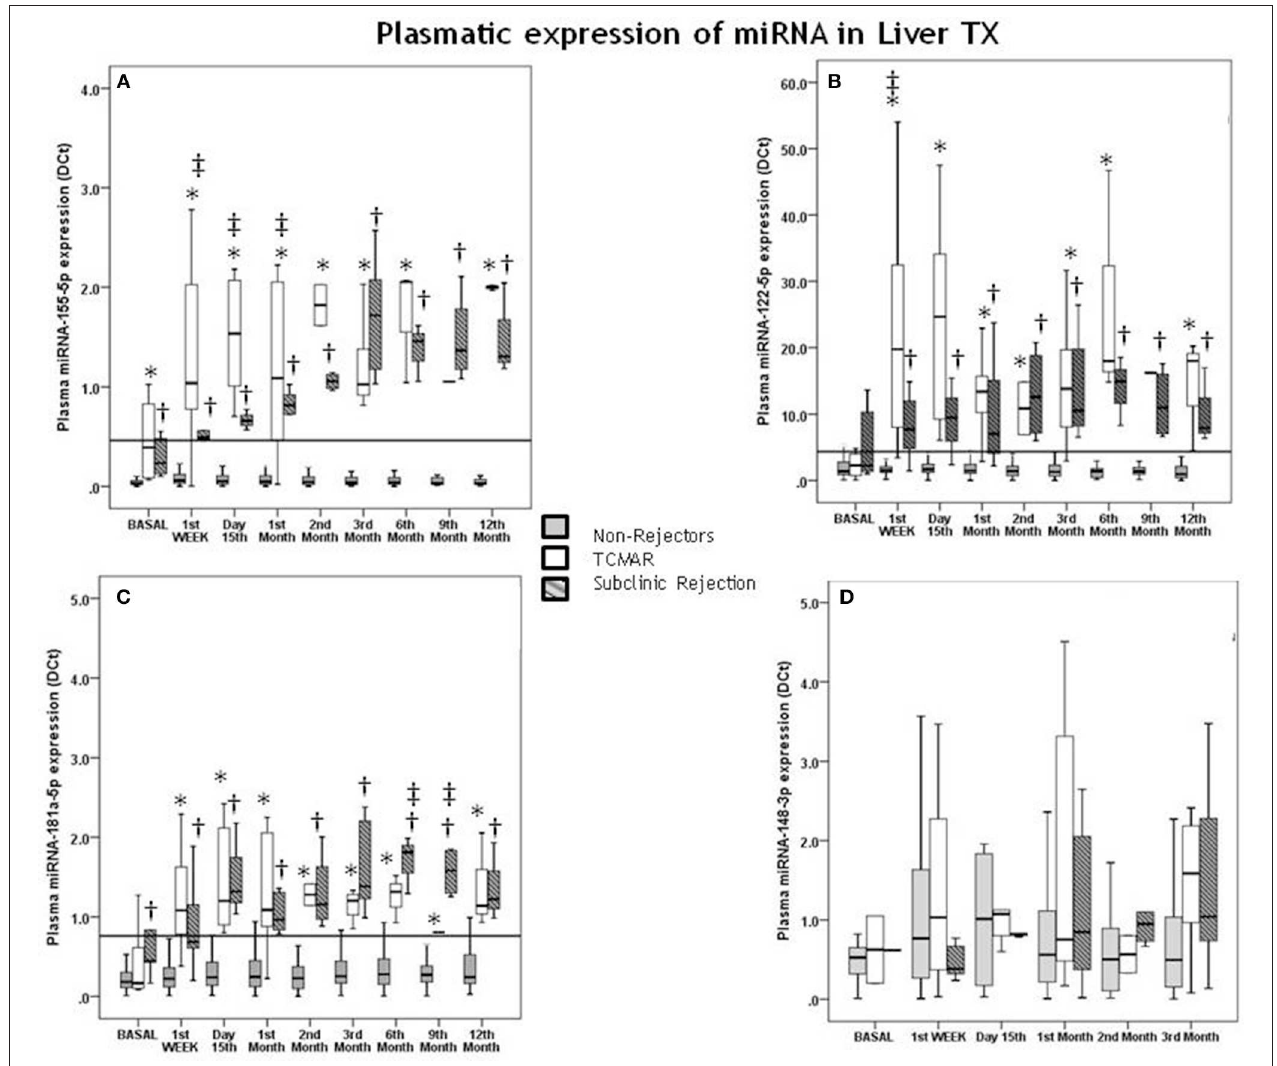
FIGURE 1 | Correlation of pre- and post-transplantation plasmatic miRNA expression with acute rejection (TCMAR) and subclinical rejection (SCR). Differences between TCMAR patients (white boxes), non-rejectors (gray boxes) and subclinical rejectors (gray hatched boxes) with respect to miR-155-5p (A) , miR-122-5p (B) , miR-181a-5p (C) , and miR-148-3p expression (D) , over 1 year post-transplantation. Seventeen of the 145 patients experienced TCMAR episodes (3 episodes occurred during the 1st week post-transplantation, 6 at day 15th, 4 at the end of the 1st month, 1 during the 3rd month, 1 during the 6th month, and 2 during the 12th month post-transplantation). Eight patients were diagnosed with SCR and were considered an independent group. TCMAR box-plots include data from the patients who exhibited rejection at this time plus the pre-TCMAR data of the patients who had not yet exhibited rejected at this time but who would do so in a later profile. Therefore, the number of samples that contributed to the data for both groups in each profile is as follows: non-rejectors: pre-transplantation n = 120; 1st week n = 120; 15th day n = 123; 1st month n = 129; 2nd month n = 133; 3rd month n = 133; 6th month n = 134; 9th month n = 135 and 12th month n = 135 vs. TCMAR rejectors pre-transplantation n = 17; 1st week n = 17; 15th day n = 14; 1st month n = 8; 2nd month n = 4; 3rd month n = 4; 6th month n = 3; 9th month n = 2 and 12th month n = 2. *Indicates significant differences between TCMAR and non-rejectors; †Indicates significant differences between SCR and non-rejectors; and ‡Indicates significant differences between TCMAR and patients with SCR. The solid horizontal line indicates the post-transplantation cut-off value (0.453) for miR-155-5p expression (A) , the post-transplantation cut-off value (4.356) for miR-122-5p expression (B) , the post-transplantation cut-off value (0.760) for miR-181a-5p expression (C) .